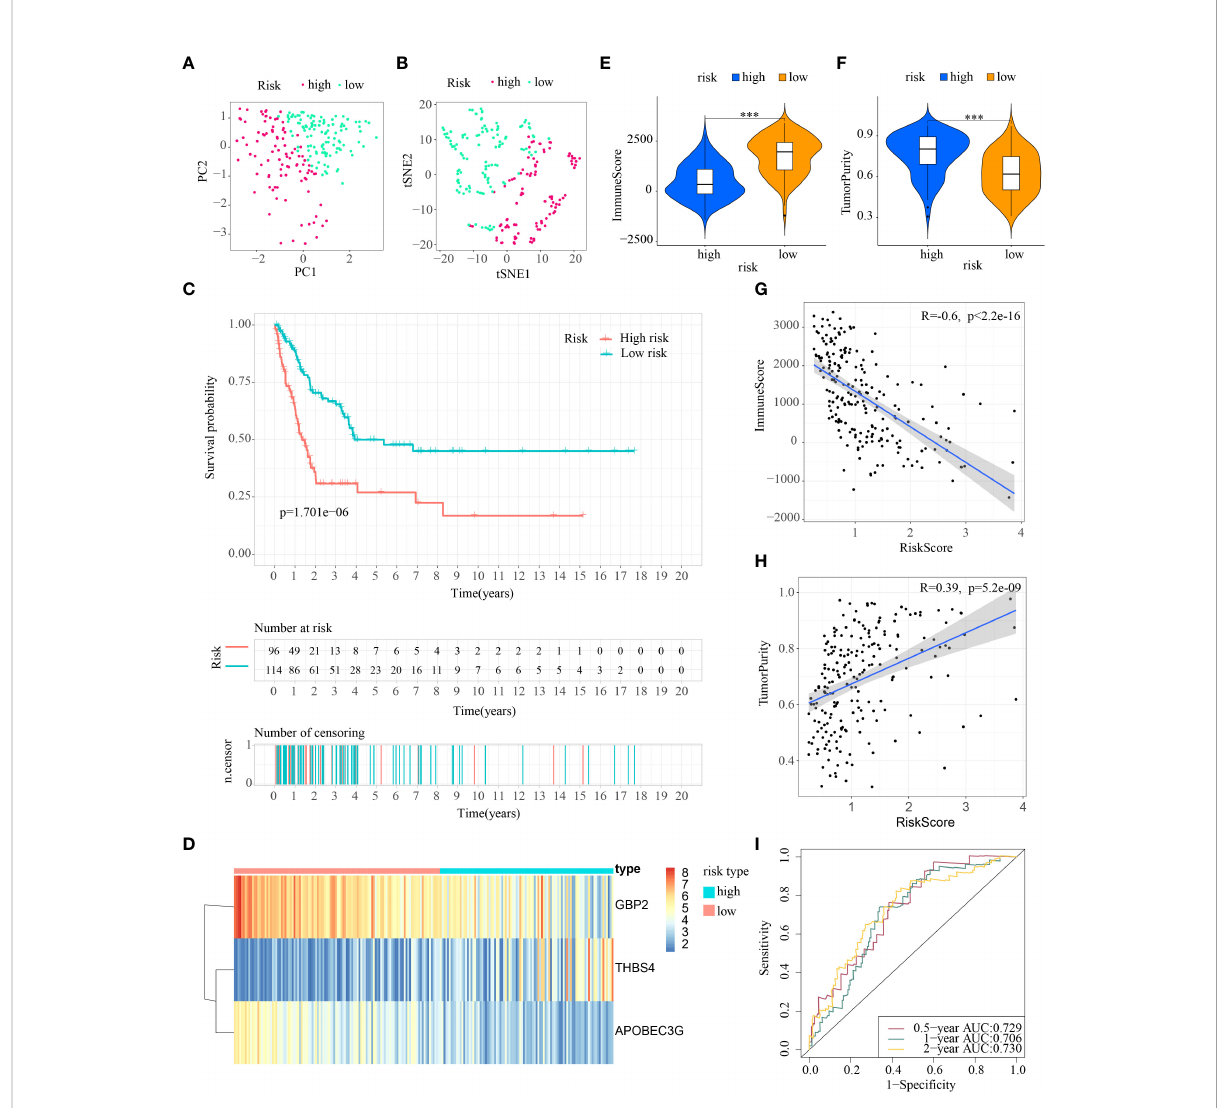
FIGURE 7 External veri fi cation of ICDRS in test3 cohort. (A, B) PCA and t-SNE analysis illustrated an excellent clustering performance of the ICDRS-based risk score; (C) Kaplan – Meier survival curves for the overall survival of two risk groups in the test3 cohort; (D) Distribution pattern of the expression levels of the 3 genes in the test3 cohort; (E, F) Comparing TME components in test3 cohort (*** indicates p < 0.001); (G) The correlation between ImmuneScore and risk score; (H) The correlation between TumorPurity and risk score; (I) AUC values of 0.5-, 1-, and 2- year in the test3